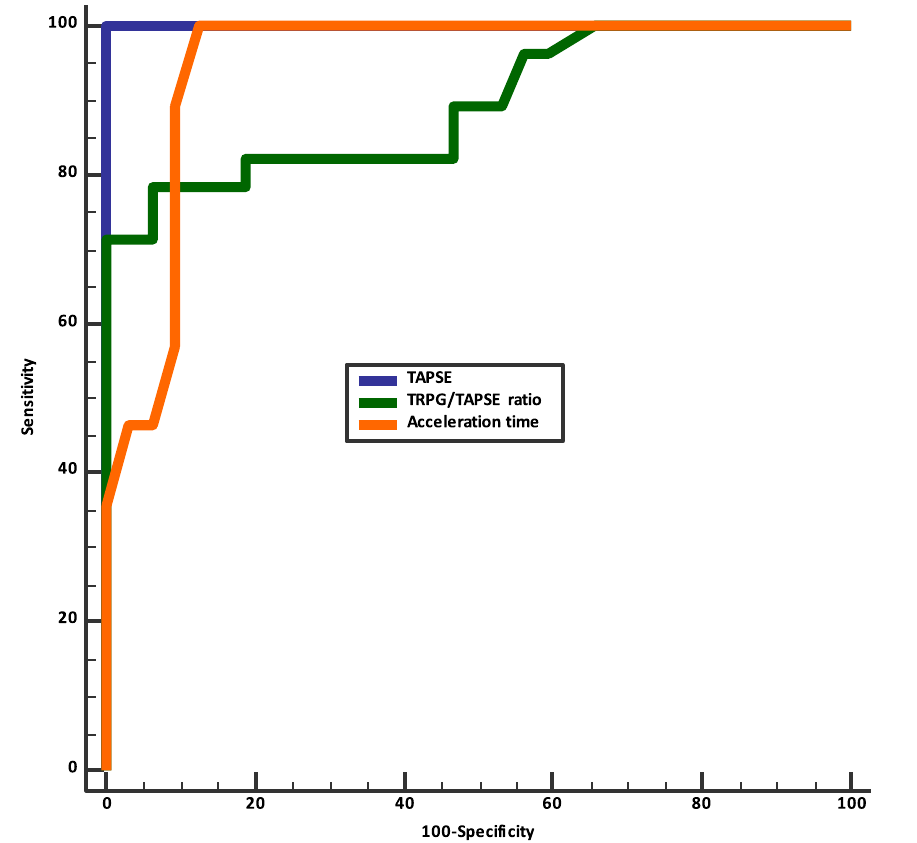
Fig. 1 Accuracy of new parameters in prediction of intermediate‑high‑risk